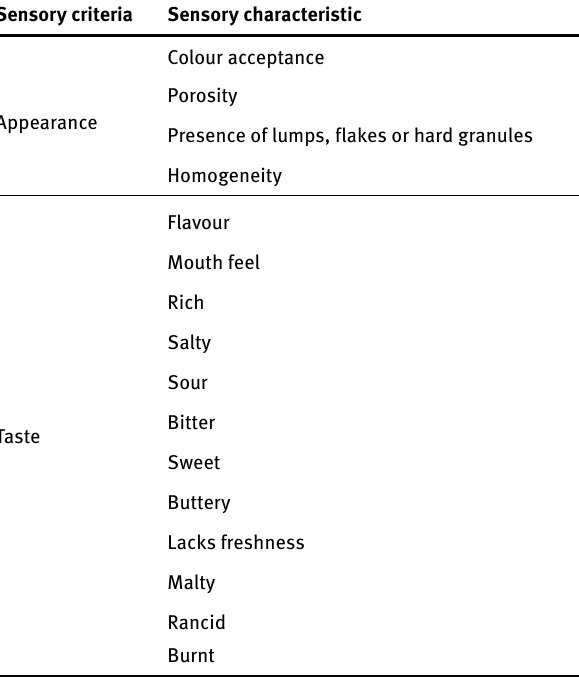
Table 4: Characteristic of the sensory